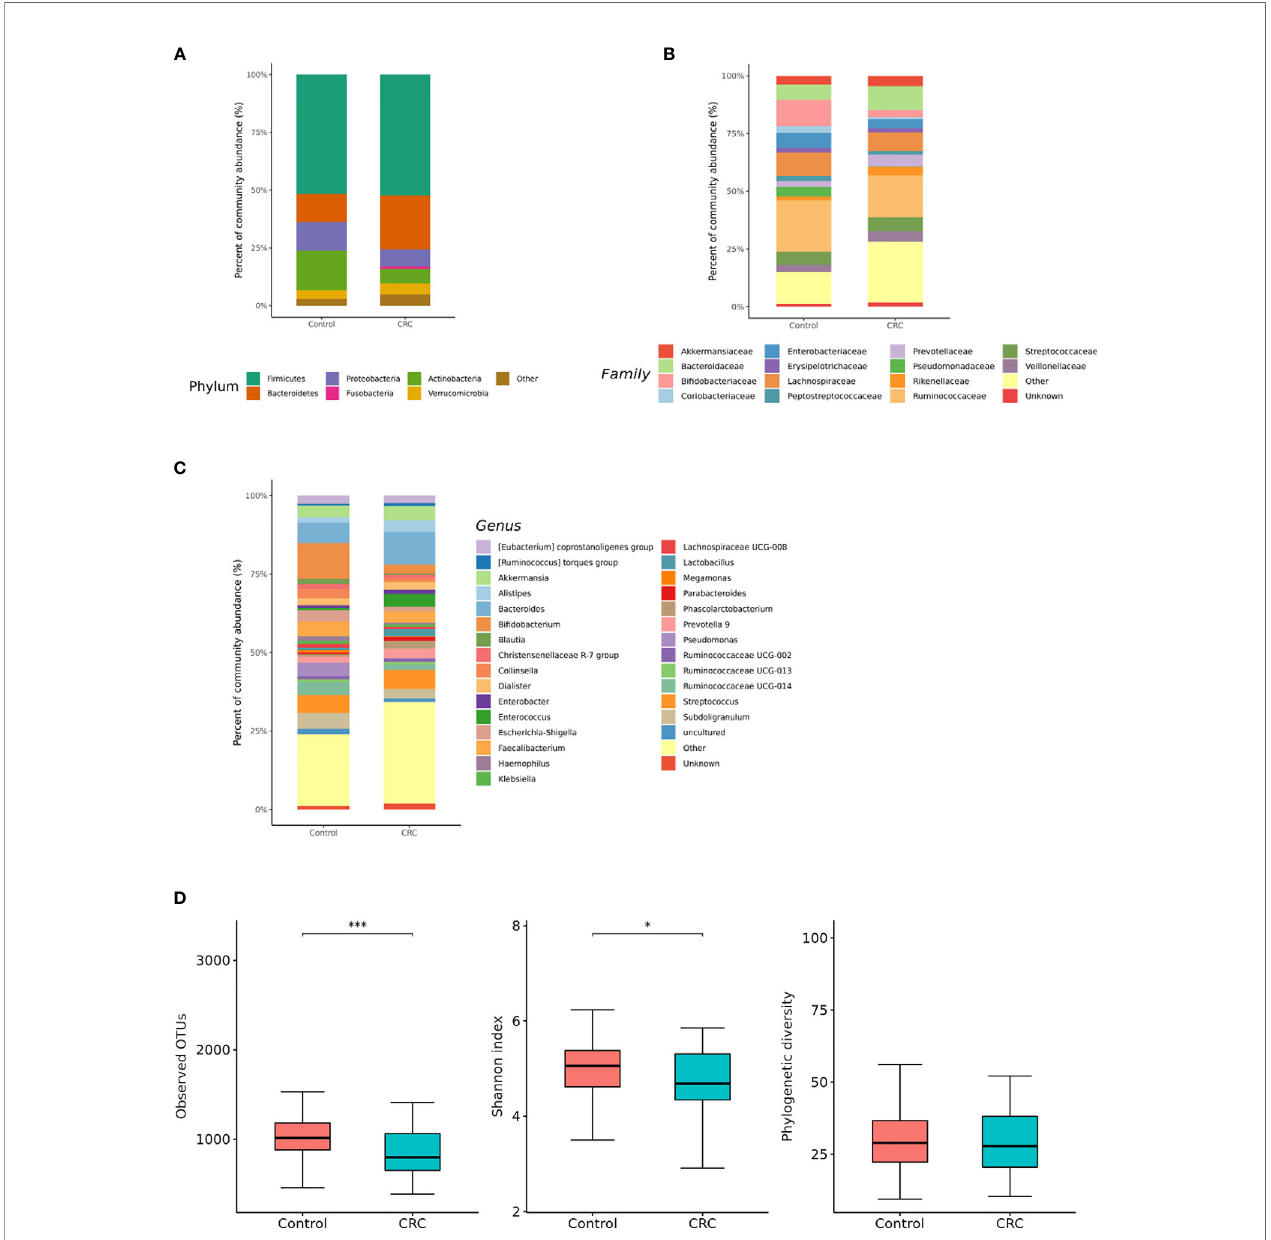
FIGURE 1 | Relative abundance plots of the gut microbiota of control (n = 158) subjects and CRC subjects (n = 70) (A) at the phylum, (B) family, and (C) genus levels. (D) Boxplots of alpha diversity indices comparing CRC with control in the gut microbiota. *** p < 0.005 and * p < 0.05. CRC; colorectal cancer, OTU; operational taxonomic